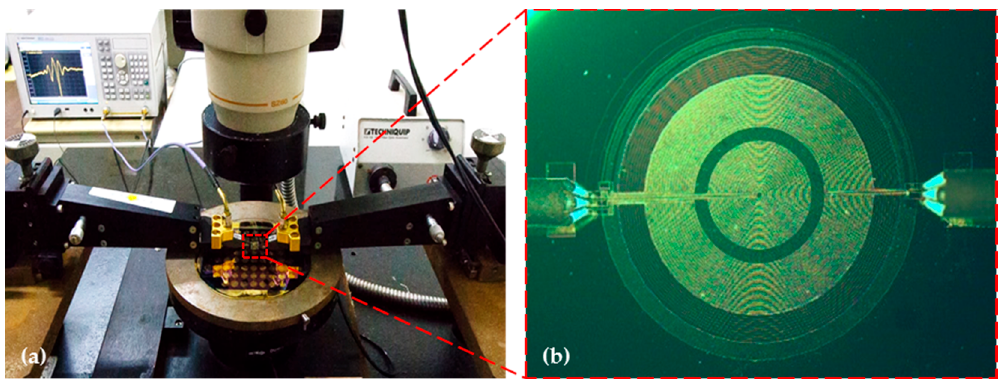
Figure 7. ( a ) On-chip measurement setup proposed in this study for characterization of the presented FPW devices. ( b ) Optical micrograph of the implemented FPW device with the circular IDTs/RGS configuration.